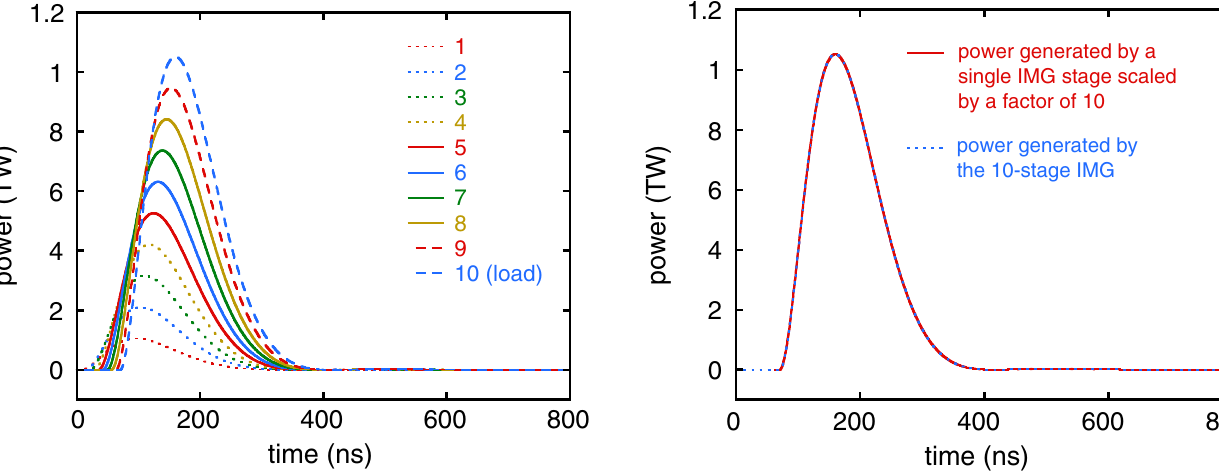
FIG. 7. Simulated electrical-power time histories at the outputs of the ten transmission-line segments of the ten-stage IMG illustrated by Fig. 4, as given by the circuit model of Fig. 5(a). Since 10 Z ¼ Z , the power at the output of the tenth stage is load identical to that at the